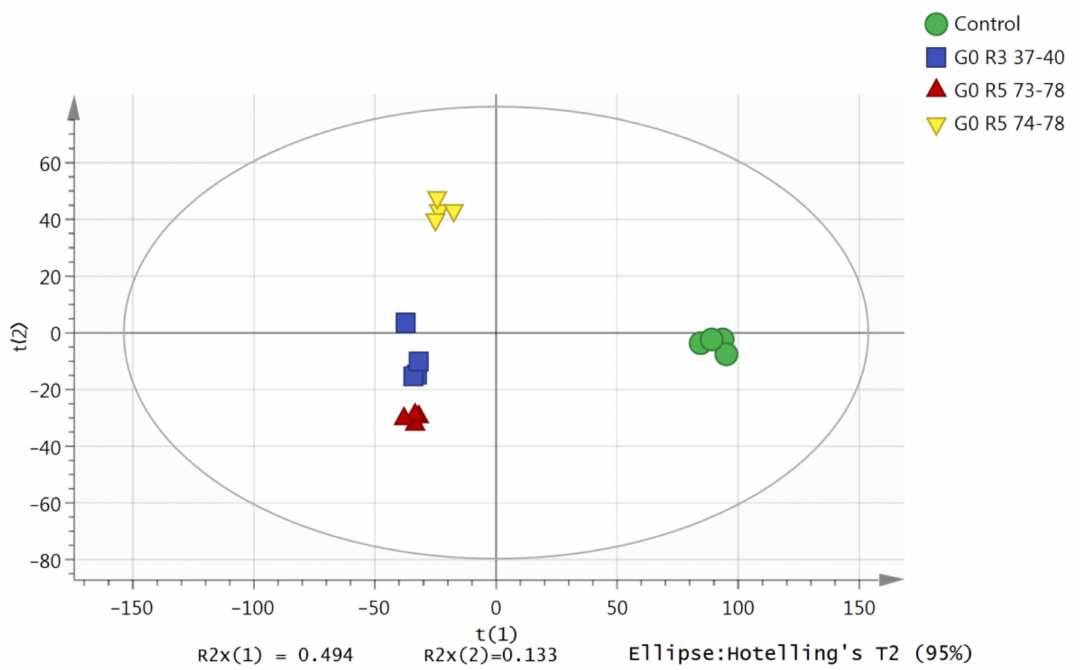
Figure 2. Principal Component Analysis (PCA) score plot of the metabolic changes of the control and co-culture of the S. parasiticum and G. boninense fractions in the first two principal components (PC1 and PC2). G0, G3 and G5 refer to the G. boninense growth age (0, 3 and 5 days), respectively. R3 and R5 represent fractions recycled number at number 3 and number 5,